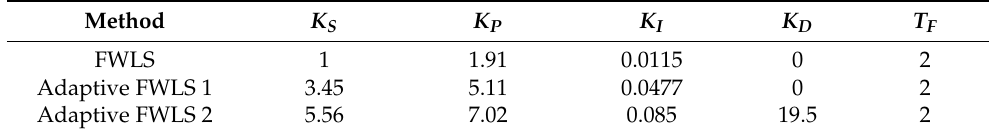
Table 3. The closed-loop parameters for FWLS, adaptive FWLS 1 and adaptive FWLS 2 methods. Method